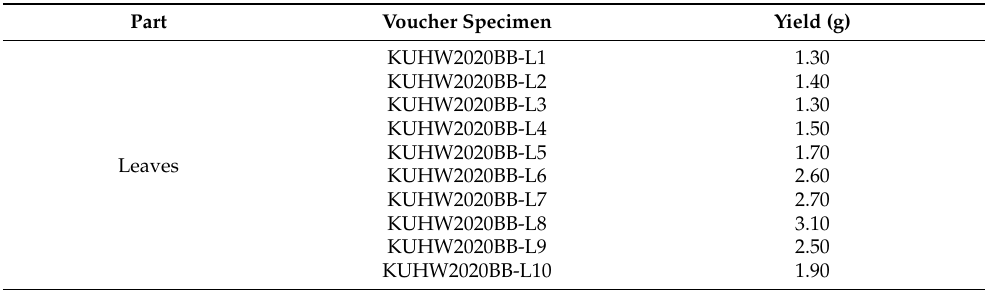
Figure 1. The integrated mass spectra of water extracts of V. virgatum aerial parts: ( A ) leaves, ( B ) stems, ( C ) leaf/stem mixtures. Table 1. The yield of water extracts of V. virgatum leaves, stems, and leaf/stem